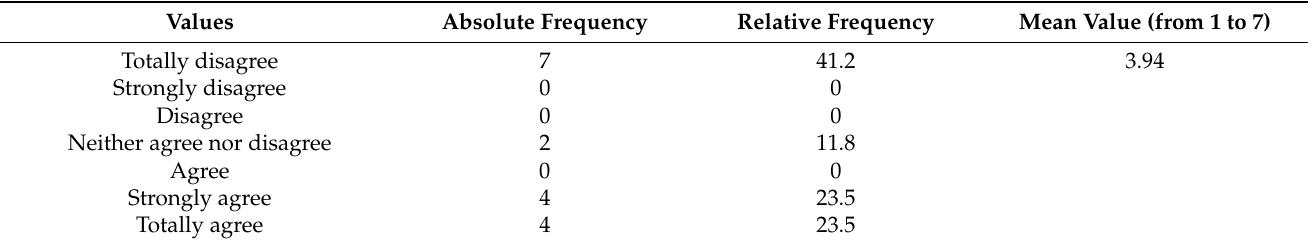
Table 4. Analysis of the results for item 4: “I have faced barriers to promotion over the course of my academic career”.